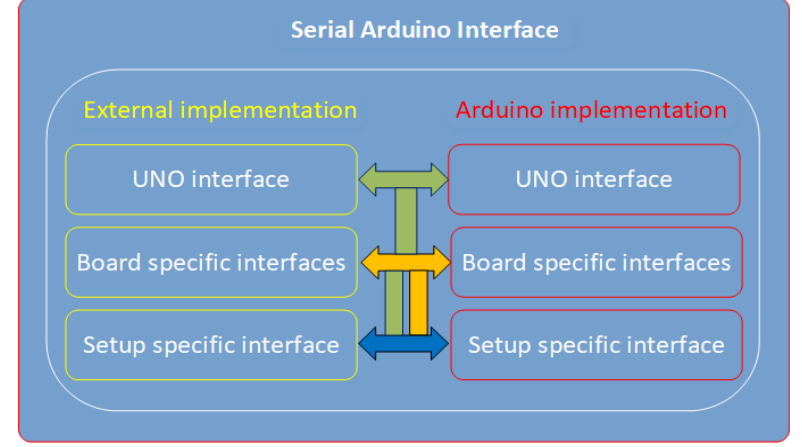
Fig. 3. Three level ASI